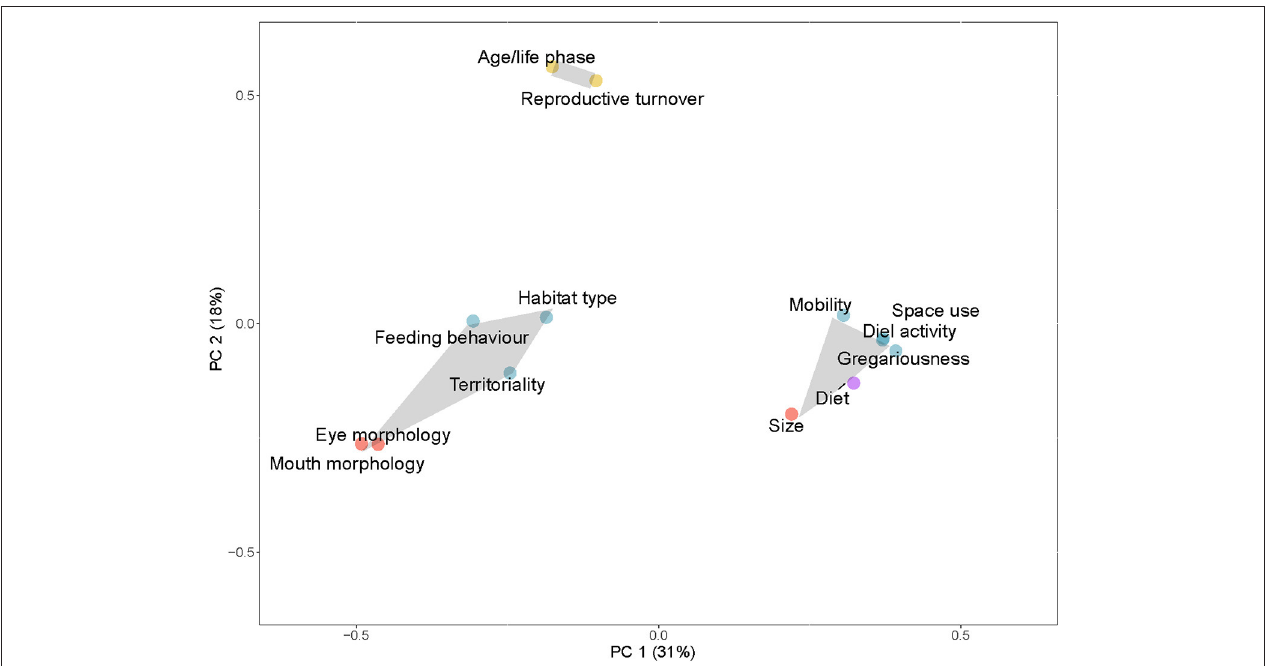
FIGURE 3 | PCoA plot of traits used to estimate functional diversity or to determine functional entities. Three clusters show traits commonly used together in functional diversity metrics. Color of trait points corresponds to broad trait groupings (blue: behavioral, yellow: life-history, red: morphological, gray: physiological, purple: